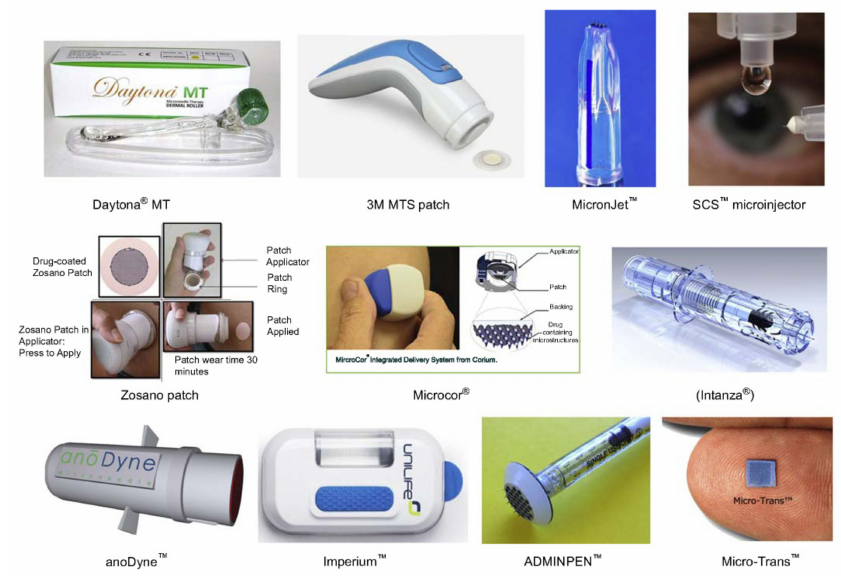
Figure 3. Current microneedle devices (single needle with applicator, microneedles array patch, microneedles pen, microneedle pump patch, and microneedle roller) [36]. Reprinted from Emerging nanotechnologies for diagnostics, drug delivery and medical devices, Rubi Mahato, Microneedles in Drug Delivery, 331–353, Copyright (2017), with permission from